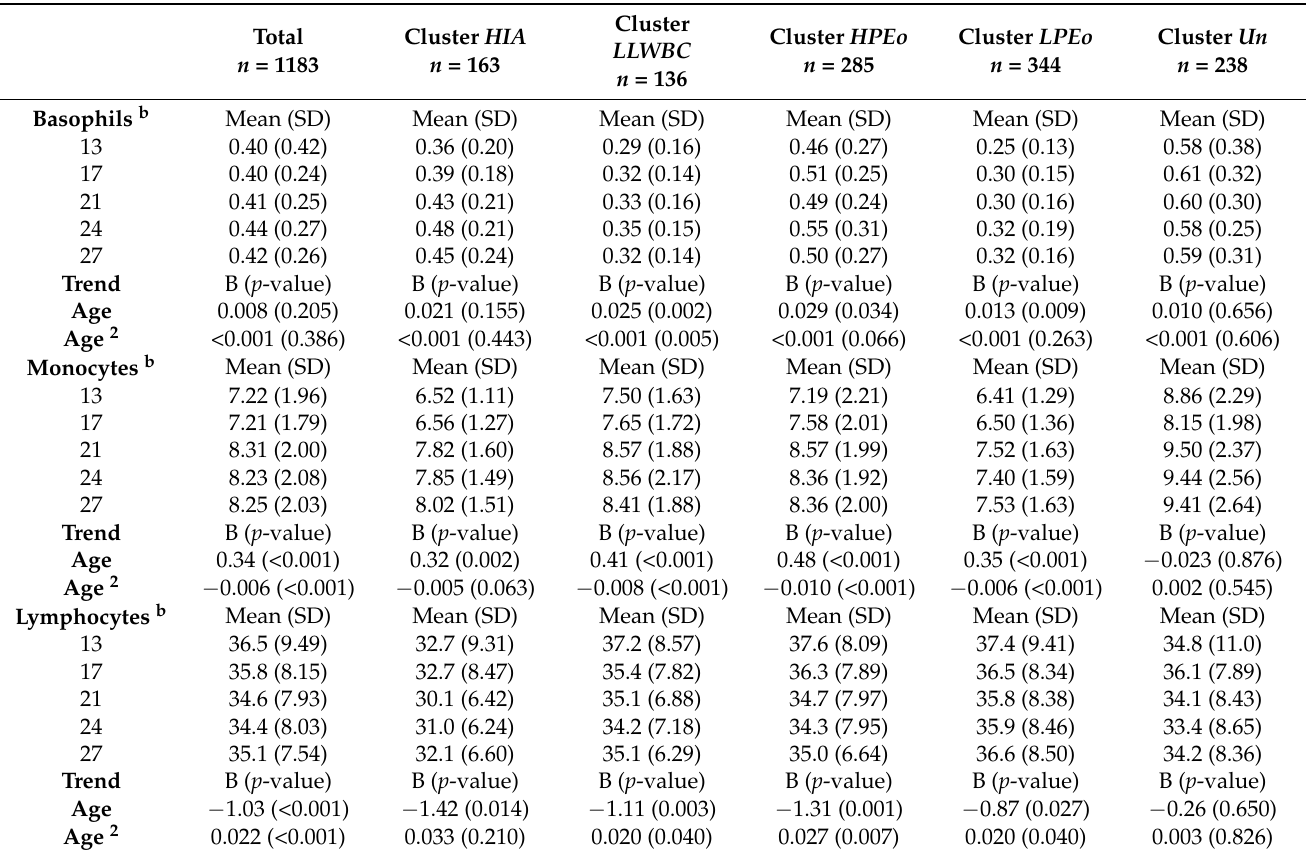
Table A2. Description of the total and differential white blood cells (WBC) at 13, 17, 21, 24 and 27 years of age according to the